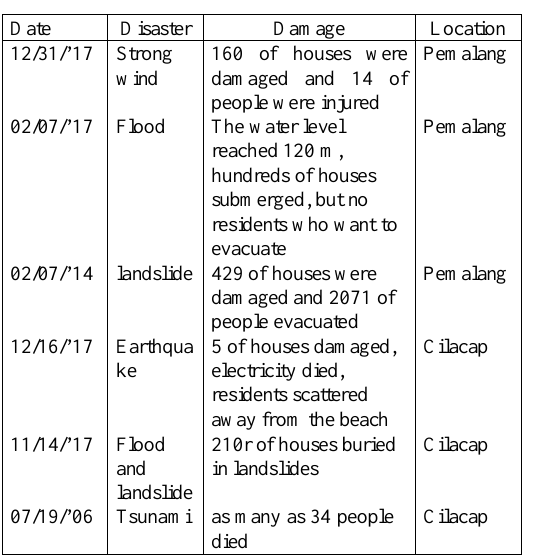
Table 4. A number of disasters that attacked Pemalang and